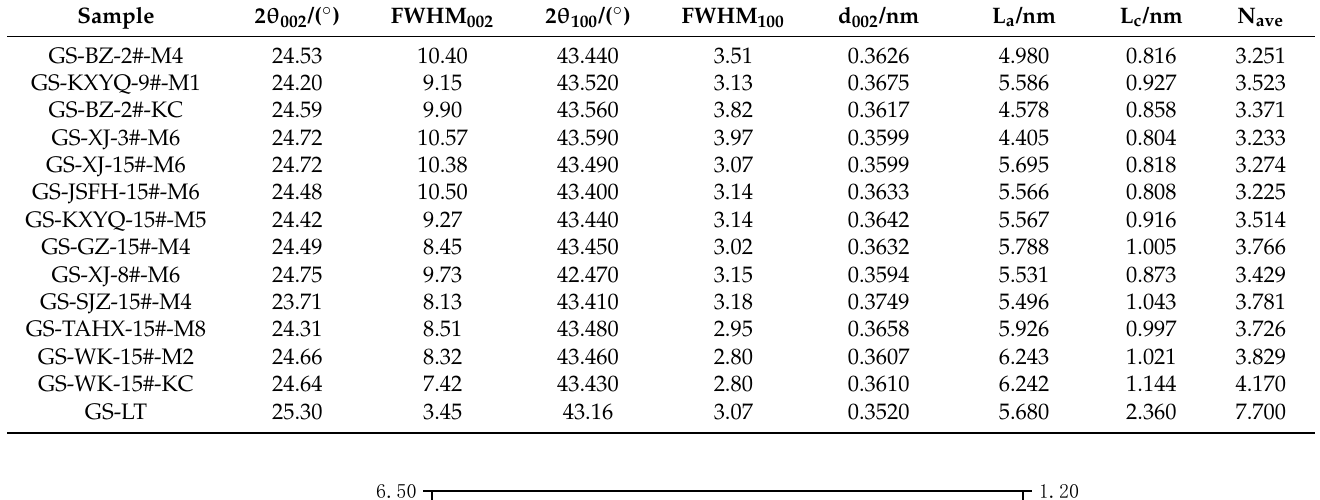
Figure 5. XRD patterns of coal-based graphene. Table 4. XRD parameters coal-based graphene.